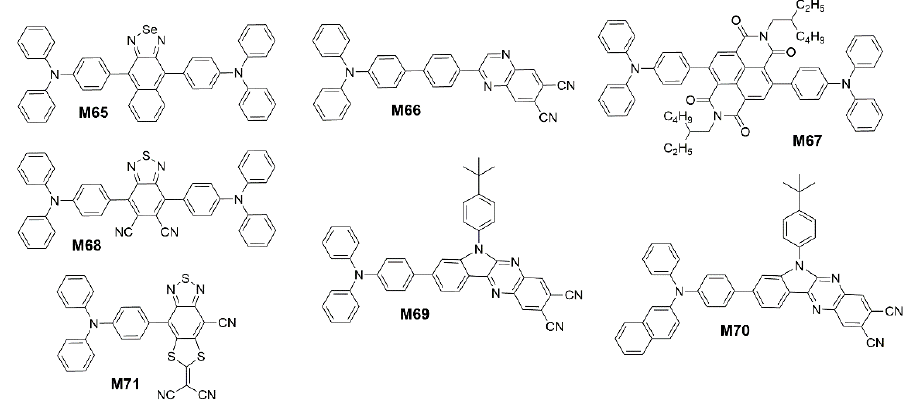
Figure 20. Chemical structures of M65 to M71 .